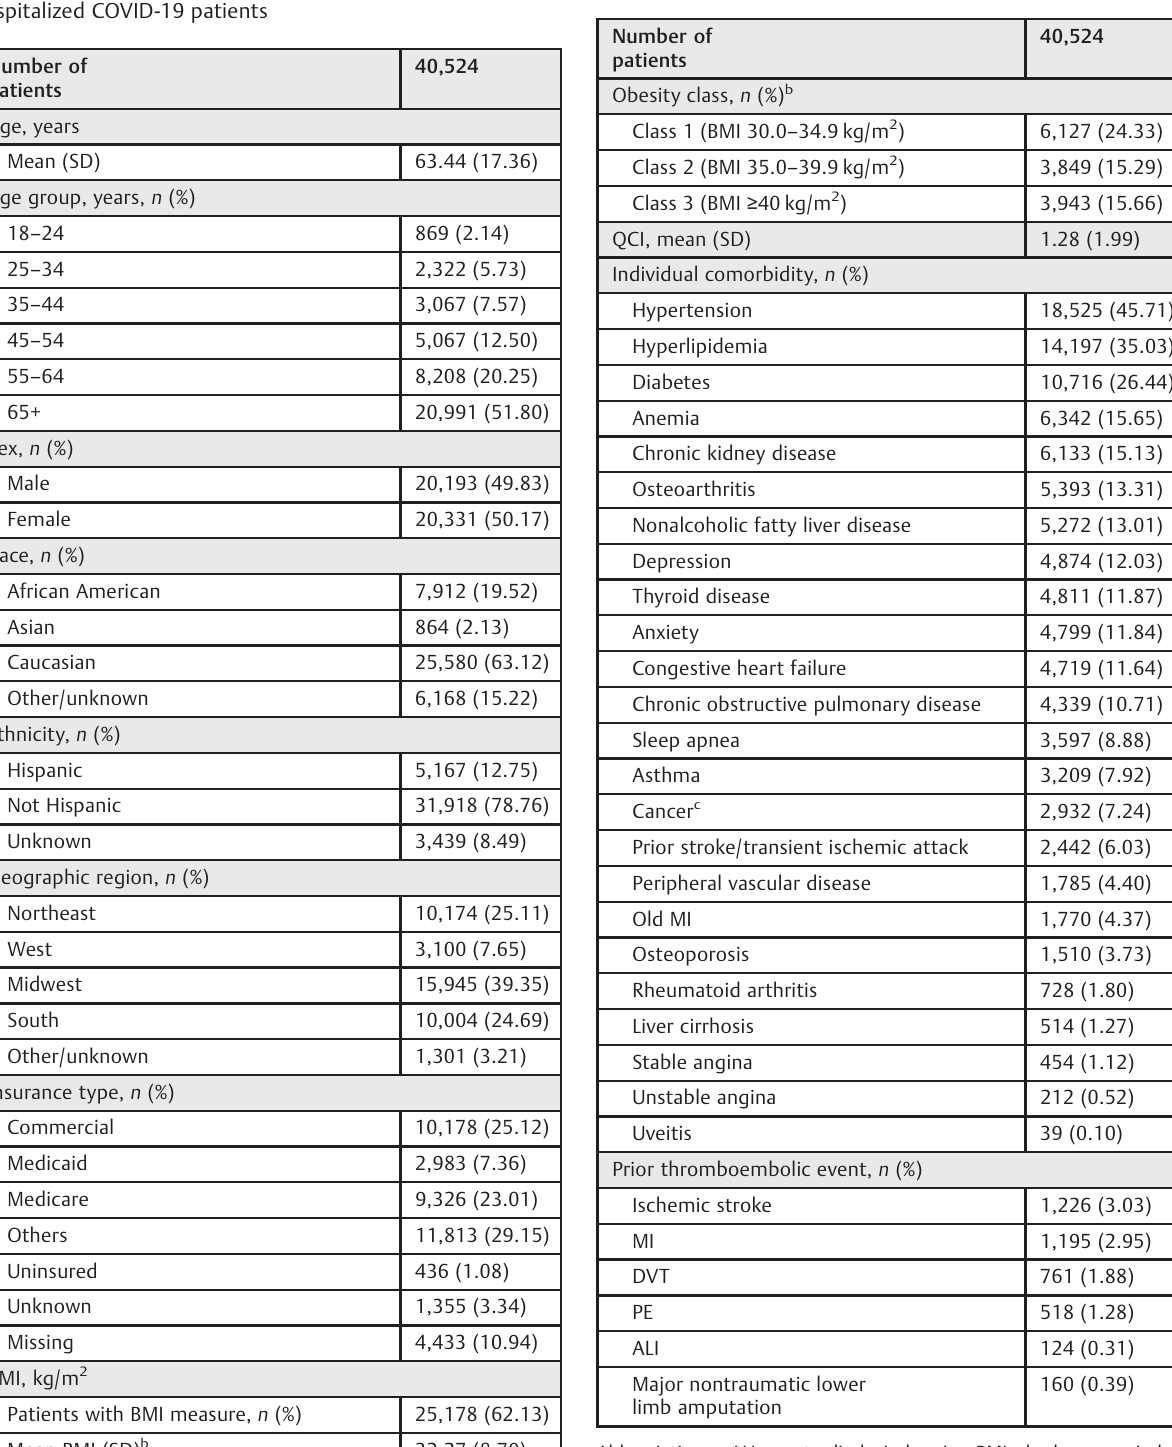
Table 1 Demographics and baseline a clinical characteristics